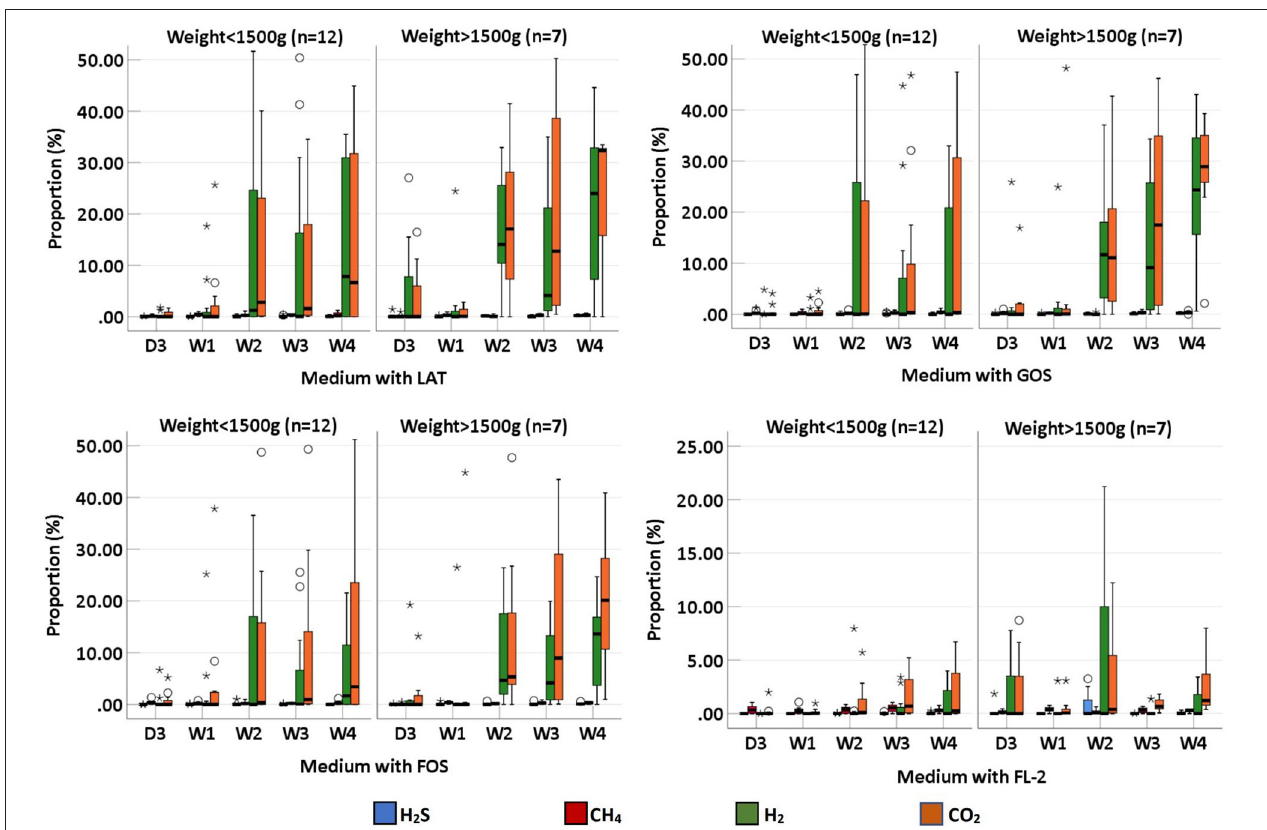
FIGURE 3 | The proportion of intestinal gas composition (CO 2 , H 2 , CH 4 , and H 2 S) of preterm infants of different ages, stratified by weight ( < 1,500 and > 1,500g); D3, 3 days after birth; W1, 1 week after birth; W2, 2 weeks after birth; W3, 3 weeks after birth; W4, 4 weeks after birth; LAT, lactose; FOS, fructooligosaccharide; FL-2, milk oligosaccharide; GOS, galactooligosaccharide; *, extreme value; ◦ , discrete